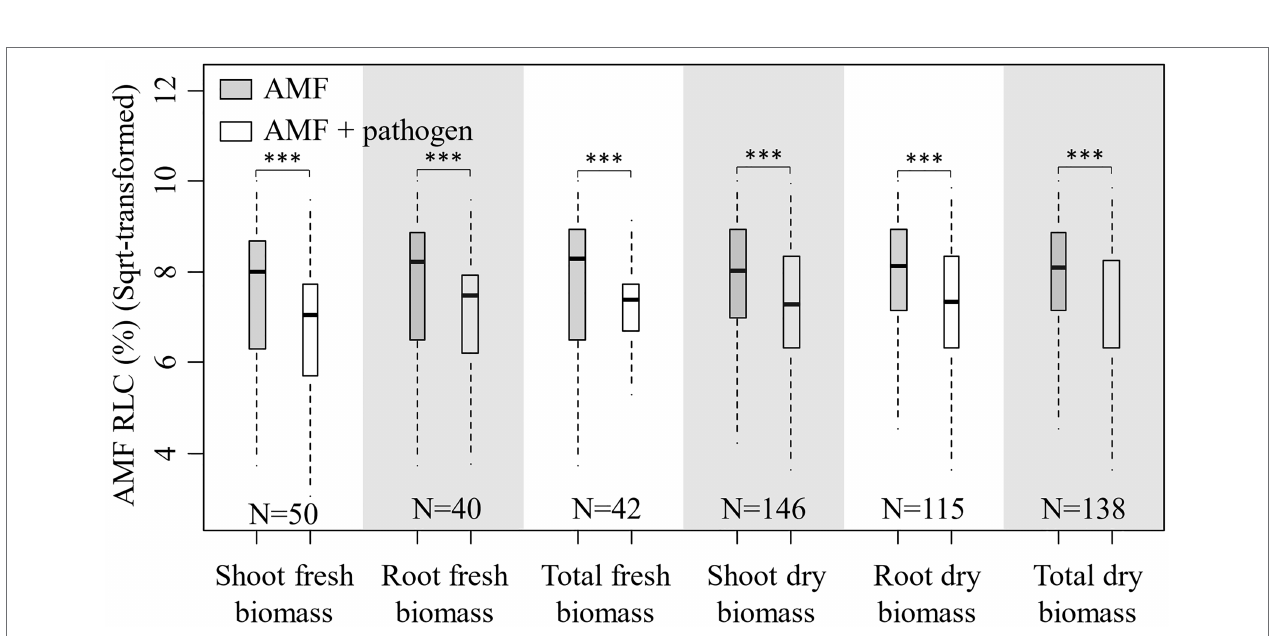
FIGURE 1 | The effect of AMF and pathogenic microbes on plant fresh and dry biomass. Values near the error bar were numbers of observations included in the